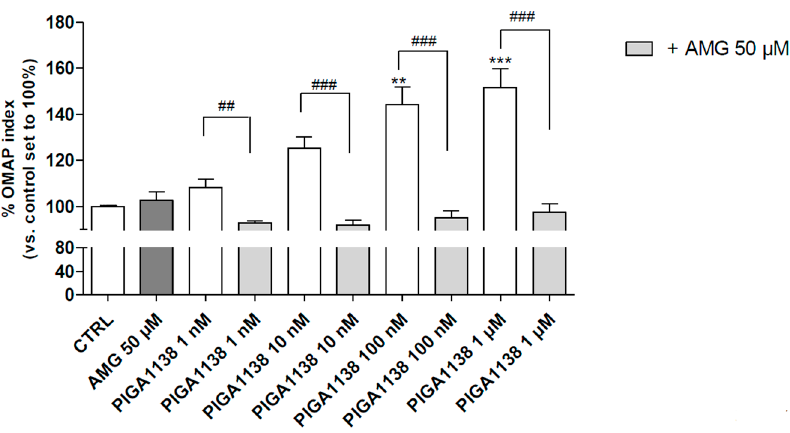
Figure 4. Influence of pregnenolone production on the U87MG OMAP index. U87MG cells were treated with different concentrations of PIGA ligands (1 nM–10 µM) in the absence or presence of AMG (50 µM) in serum-reduced media (1% FBS), and the viable cells were counted after 48 h of treatment using the MTS assay. The data are expressed as percentages of the OMAP index compared to the control, which was set to 100%, and represent the means ± SEM of three different experiments performed in duplicate. The statistical analysis was performed using one-way ANOVA and Bonferroni’s post-test; ** p < 0.01, *** p < 0.001 vs. the control; ## p < 0.01, ### p < 0.001 vs. the respective treatment without DL -aminoglutethimide (AMG).